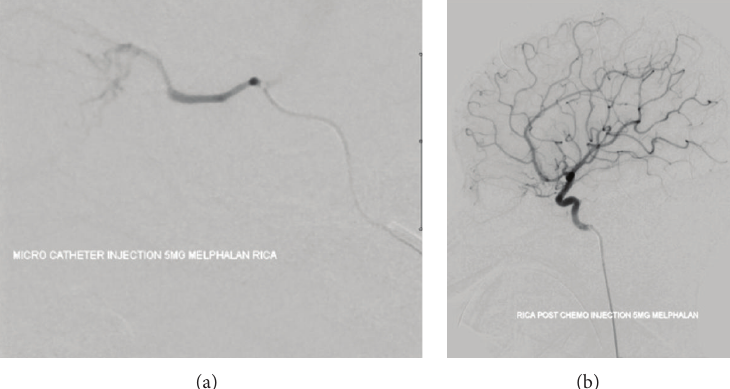
Figure 2: Digital subtraction angiography showing superselective catheterization with melphalan injection of the ophthalmic artery.